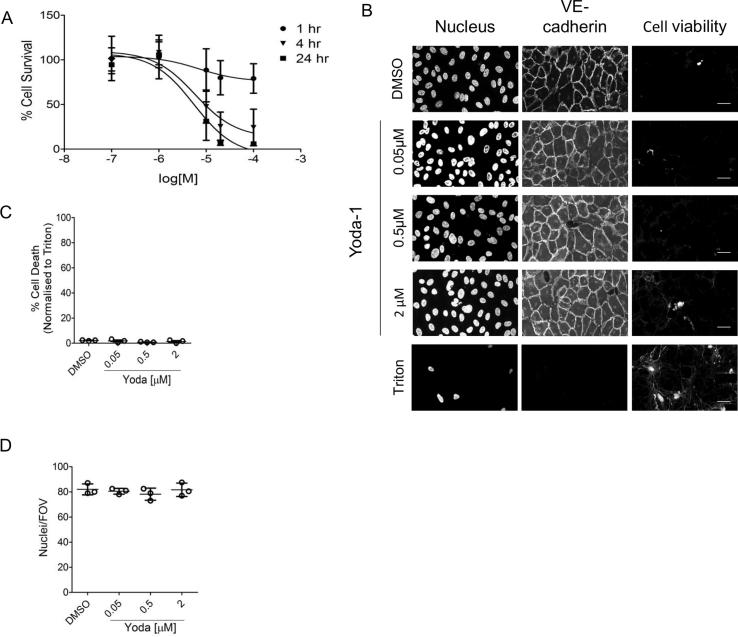
Establishing a working concentration range for Yoda-1. (A) HUVEC were exposed to a concentration range, between 100 µM and 0.1 µM, of Yoda or with the appropriate DMSO vehicle control for 1, 4 or 24 h. Cell death was quantified using an ATP luminescence commercial kit. (B) HUVEC were stimulated with Yoda-1 for 24 h then incubated with a cell viability dye (blue) prior to fixation. To visualise the nuclei and junctions, cells were incubated with bisbenzimide (red) and anti-VE cadherin (green), respectively. Representative confocal images shown. Scale bar = 20 μm. Three independent experiments with three random fields of view (FOV) were quantified per treatment, and % dead cells were normalised against 0.2% (v/v) Triton x 100 treatment. (C–D) Yoda-1-treated HUVEC were imaged and nuclei/FOV counted per treatment. Six random FOV were quantified for each individual repeat. (For interpretation of the references to colour in this figure legend, the reader is referred to the web version of this article.)